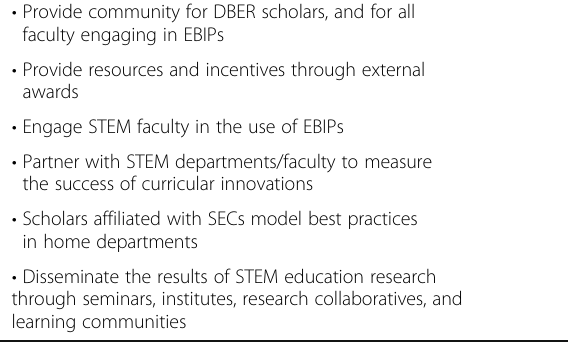
Table 7 SEC engagement in areas aligned with DBER